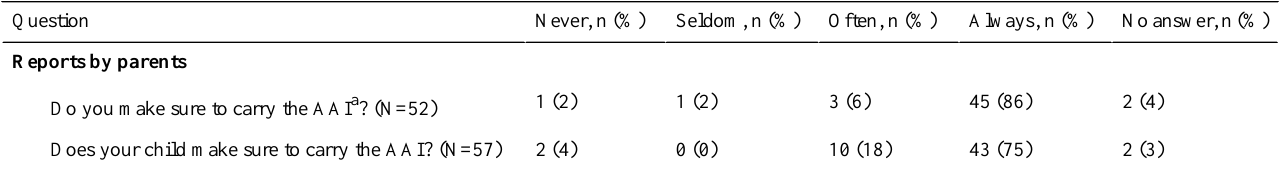
Table 5. First question about